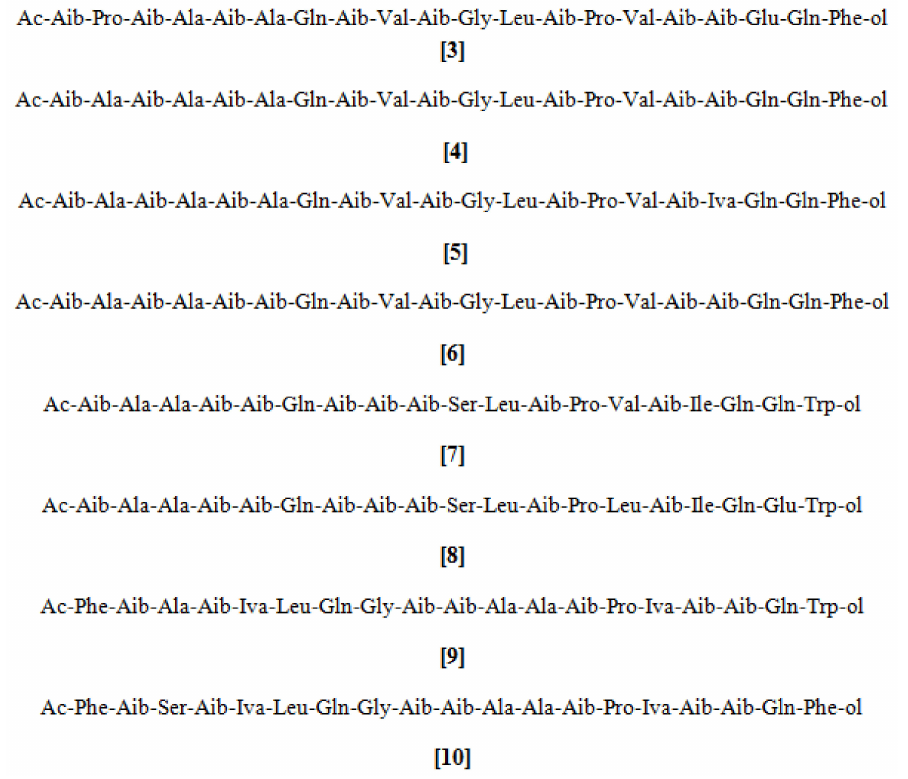
Figure 2. Structures of antifungal peptaibols from Trichoderma spp.: [3] alamethicin F30, [4] trichokonin VI, [5] trichokonin VII, [6] trichokonin VIII, [7] trichorzianine A1, [8] trichorzianine B1, [9] peptaivirin A, [10] peptaivirin B; peptaibols [4], [5], and [6] were isolated from T. koningii , [7], [8], [9], and [10] were isolated from T. harzianum